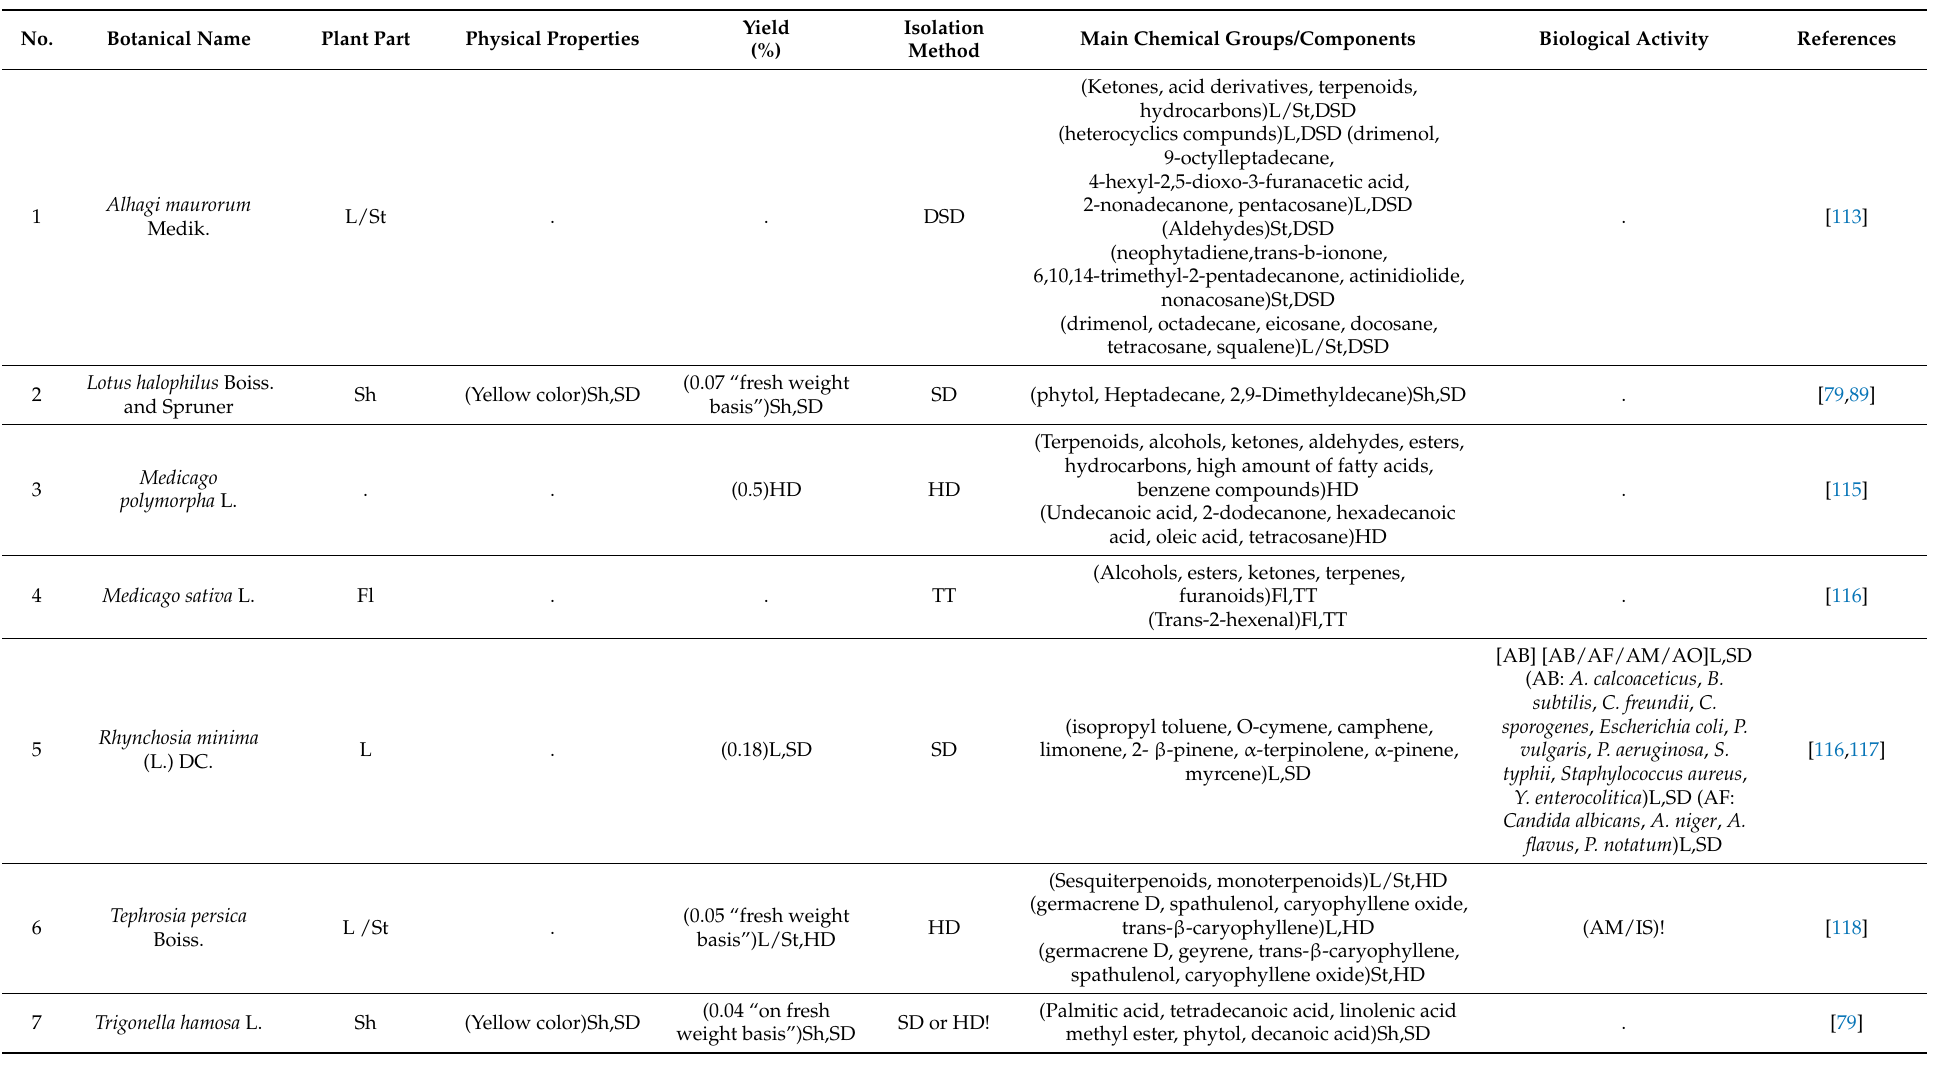
Table 9. Details of EOs isolated from species of